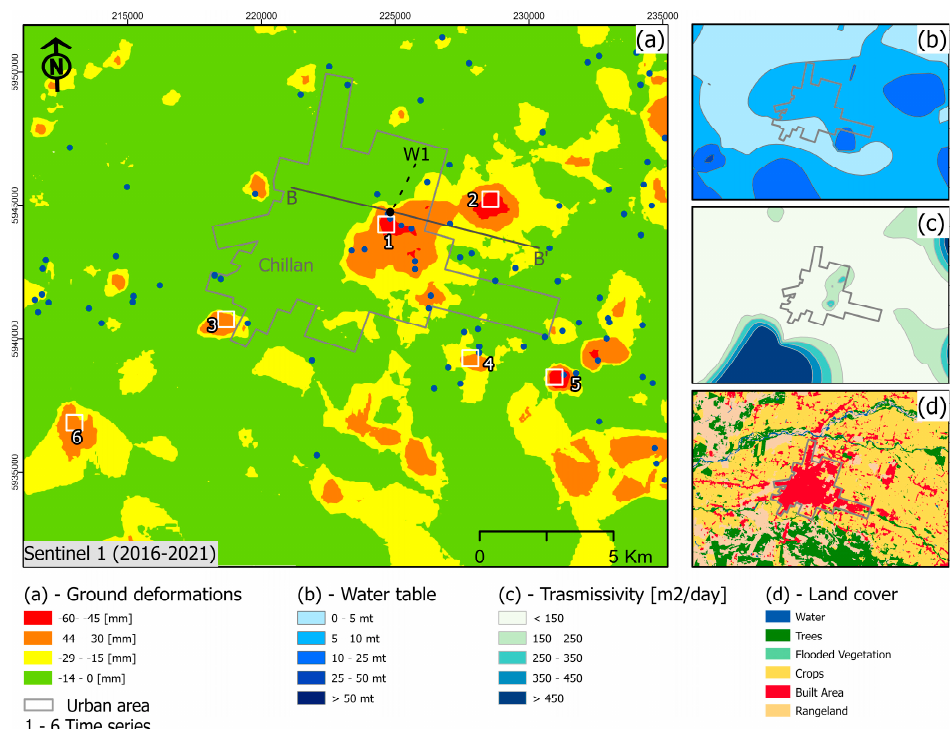
Figure 7 . ( a ) Ground deformation map [mm], ( b ) Water table map ( c ) Transmissivity map (modified from F. Avilés [44]) and ( d ) Land cover map, available in dynamic world data (Brown et al.